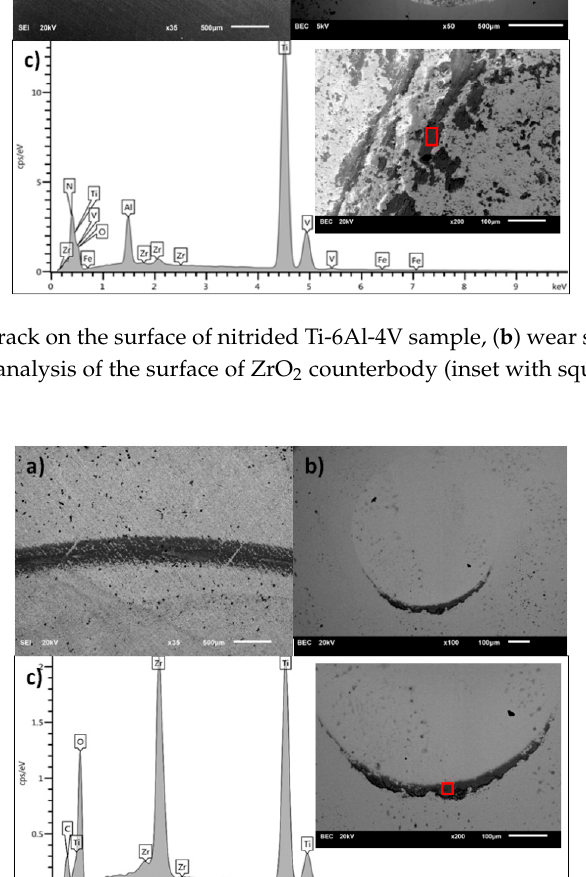
Figure 11. ( a ) Wear track on the surface of carburized Ti-6Al-4V sample, ( b ) wear scar on the ZrO 2 ball surface, ( c ) the EDS analysis of the surface of ZrO 2 counterbody (inset with square shows the place of analysis).